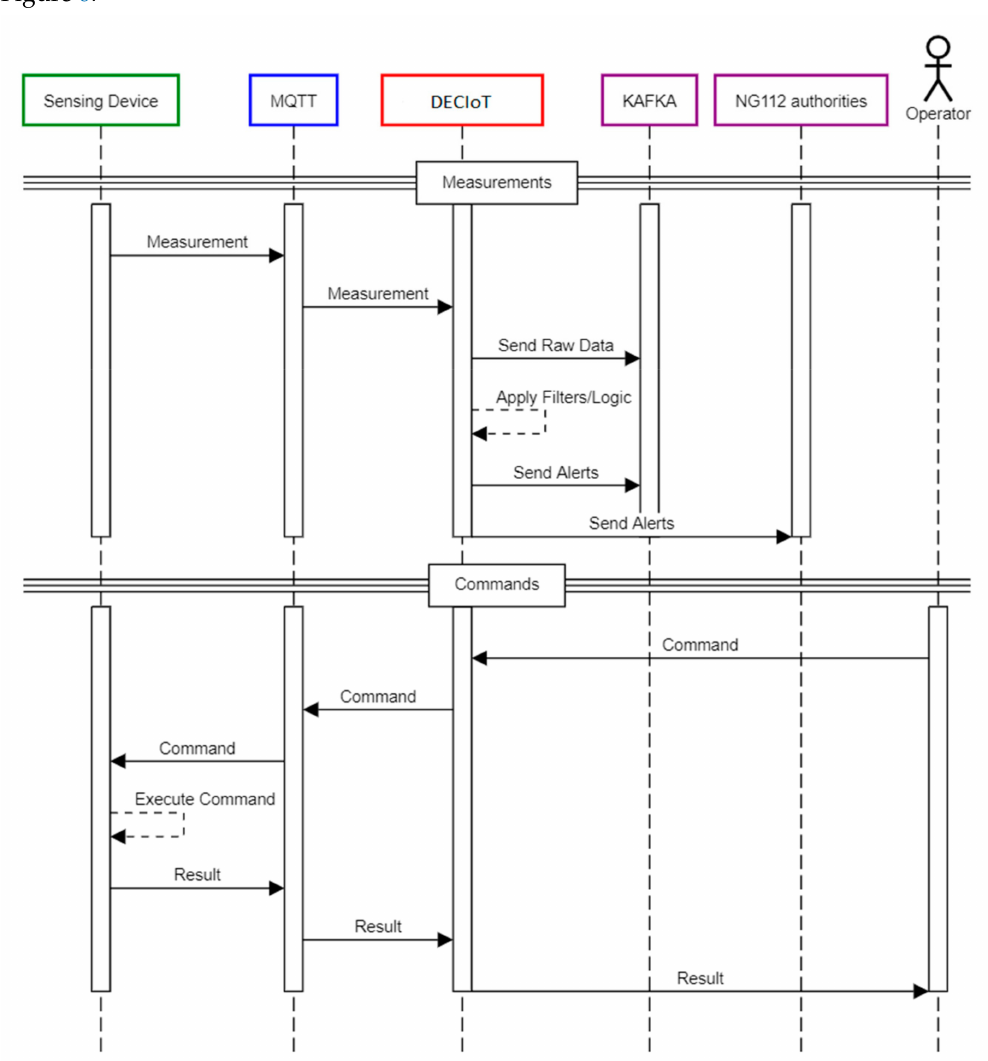
Figure 6. Sequence diagram depicting the data